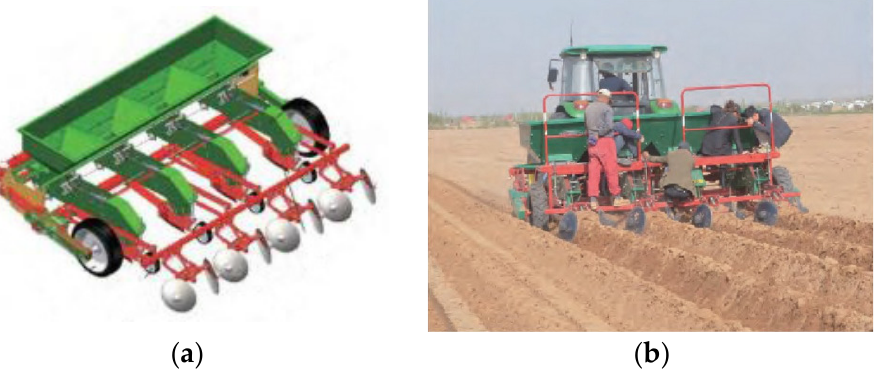
Figure 14. Vibration-arranging-based planter. ( a ) The structure of vibration-arranging-based planter. Reprinted with permission from ref. [63]. Copyright 2019 China Agricultural